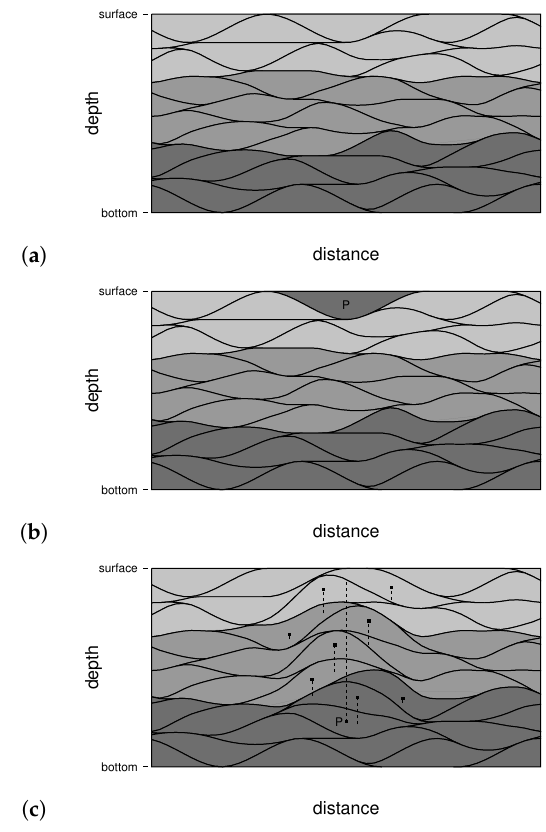
Figure 2. A schematic illustration of the Lagrangian convective parameterization. ( a ) A collection of water parcels, each having the same vertical thickness function, with darker shading denoting denser parcels. ( b ) The density of the top middle parcel (P) increases (e.g., from a temperature decrease or a salinity increase) yielding an unstable stratification. ( c ) The convective parameterization changes the stacking order of the parcels, so parcel P sinks to the level at which its density is the same as neighboring parcels. The long dashed line shows the path of the parcel center. Surrounding parcels rise slightly with short dashed lines illustrating the paths of parcel